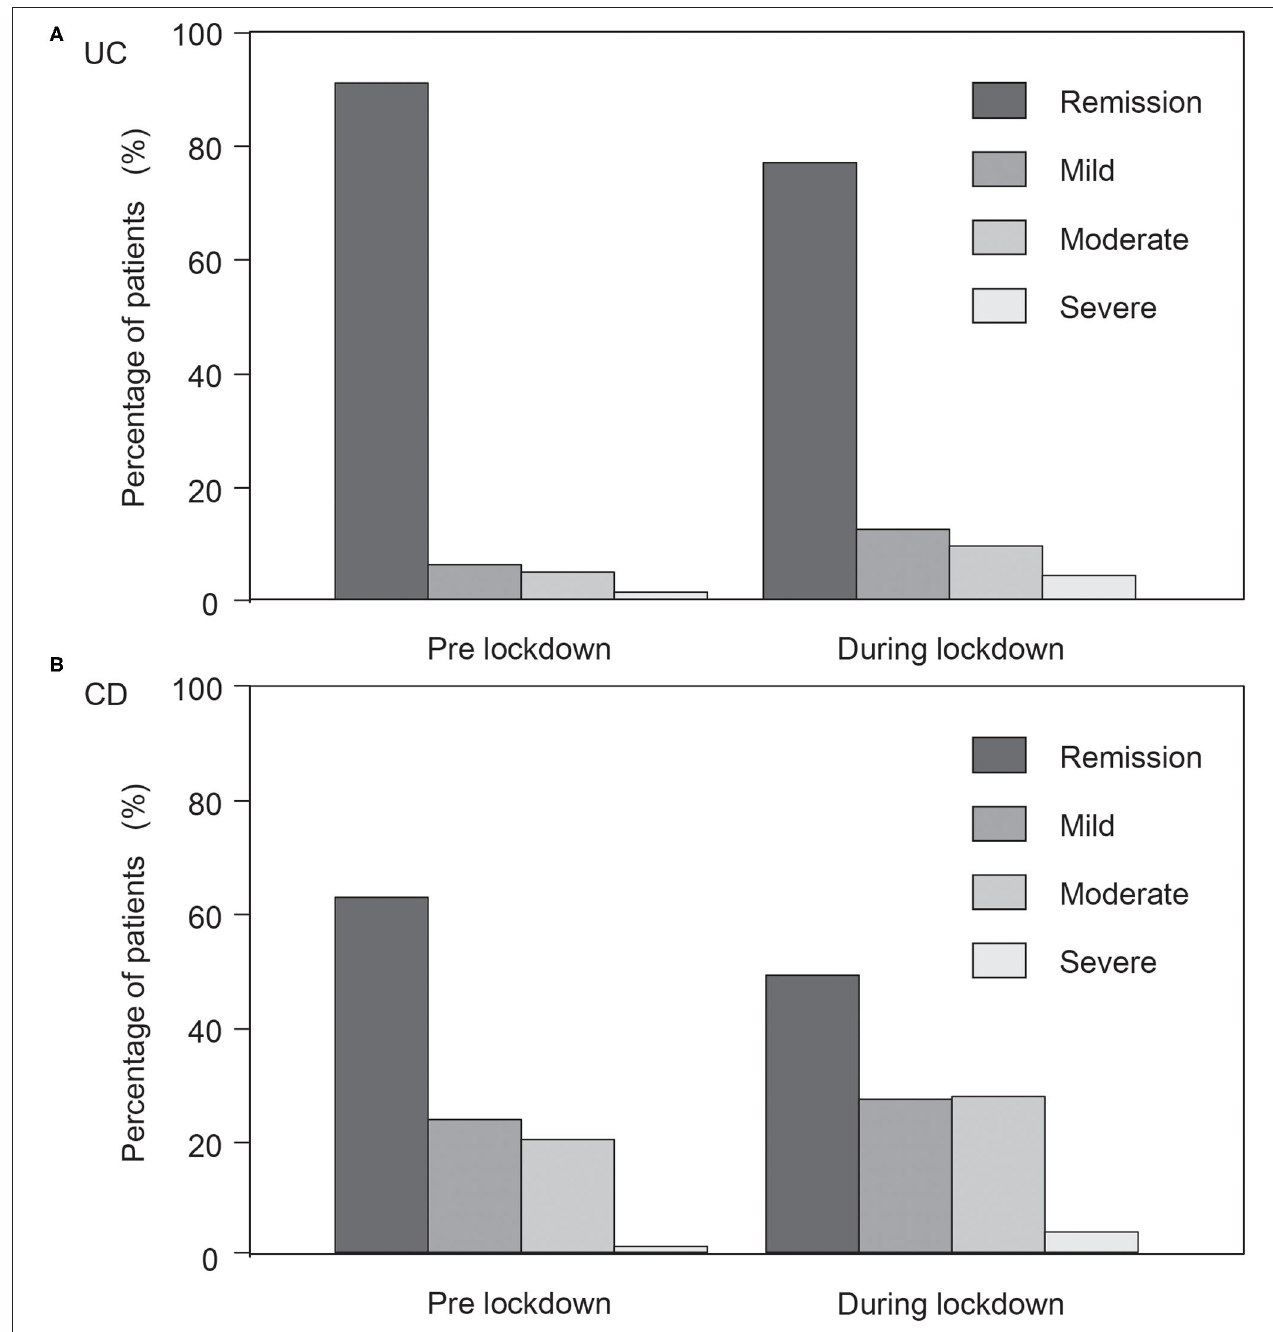
FIGURE 1 | Comparison of disease activity before and during lockdown. (A) Ulcerative colitis (UC). (B) Crohn’s disease (CD). Disease activity in UC changed as follows: remission, 213 (88.4%); mild activity, 14 (5.8%); moderate activity, 11 (4.6%); severe activity, 3 (1.2%) to remission, 180 (74.7%); mild activity, 29 (12.0%); moderate activity, 22 (9.1%); severe activity, 10 (4.1%). Disease activity in CD changed as follows: remission, 123 (58.6%); mild activity, 46 (21.9%); moderate activity, 39 (18.6%); severe activity, 2 (1.0%) to remission, 96 (45.7%); mild activity, 53 (25.2%); moderate activity, 54 (25.7%); severe activity, 2 (1.0%).